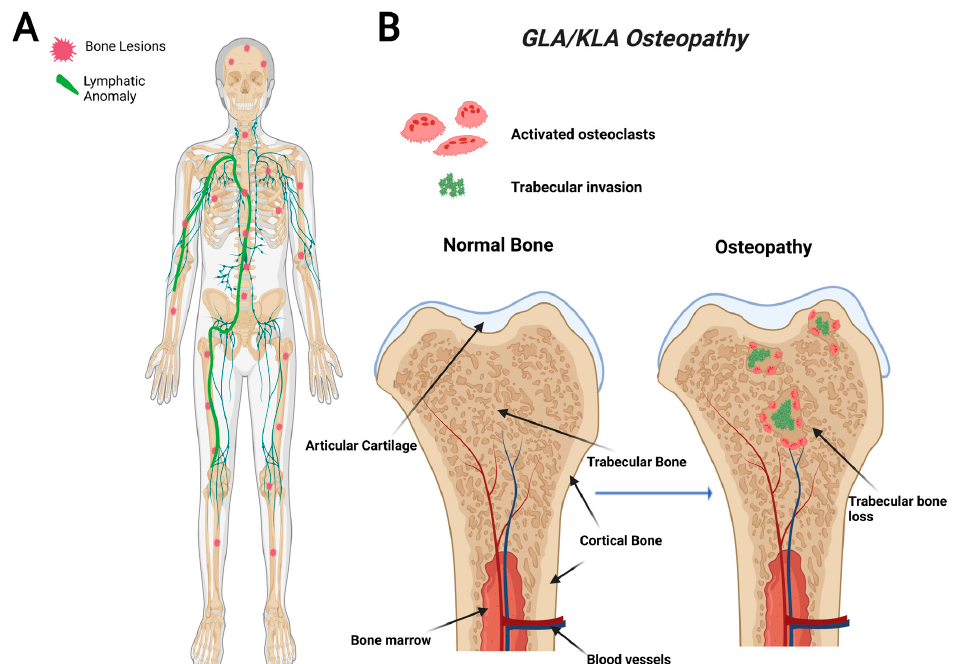
Figure 2. Visual representation of symptoms associated with Generalized Lymphatic Anomaly (GLA) and Kaposiform Lymphangiomatosis (KLA). GLA and KLA patients have generalized trabecular lytic lesions and lymphatic invasion in the thoracic cavity ( A ). Multifocal trabecular invasion is a common phenotype in GLA/KLA patients ( B